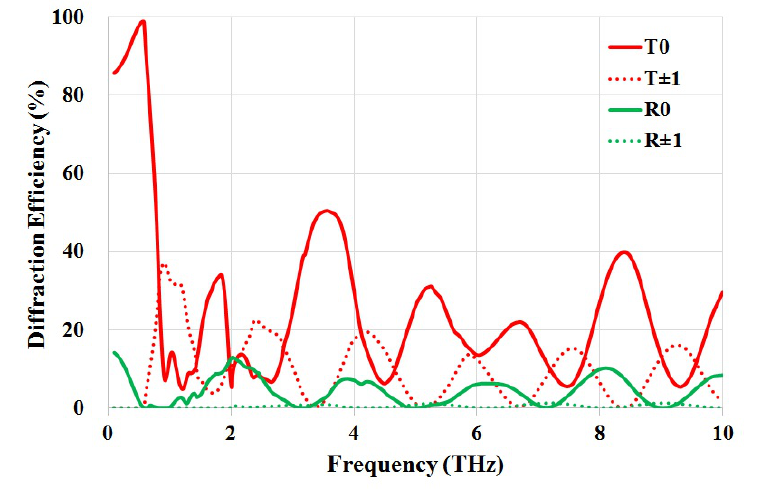
Figure 4. Calculated diffraction efficiency of the absorber using Rigorous Coupled Wave Analysis.